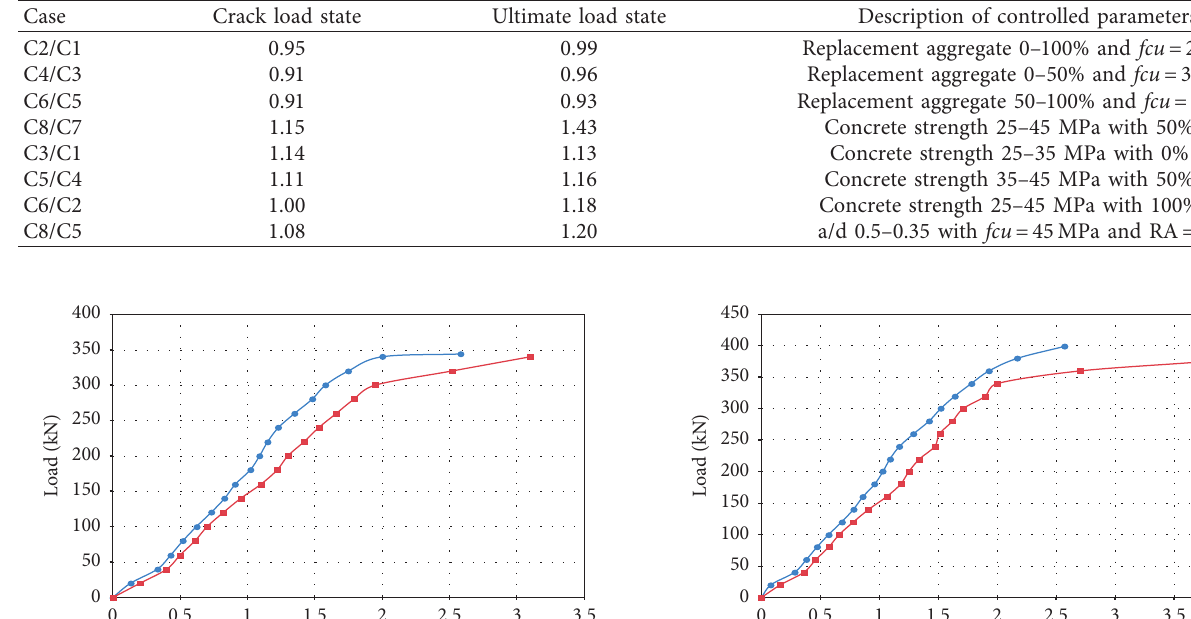
Table 10: The ratio of 8 comparison cases of corbels.